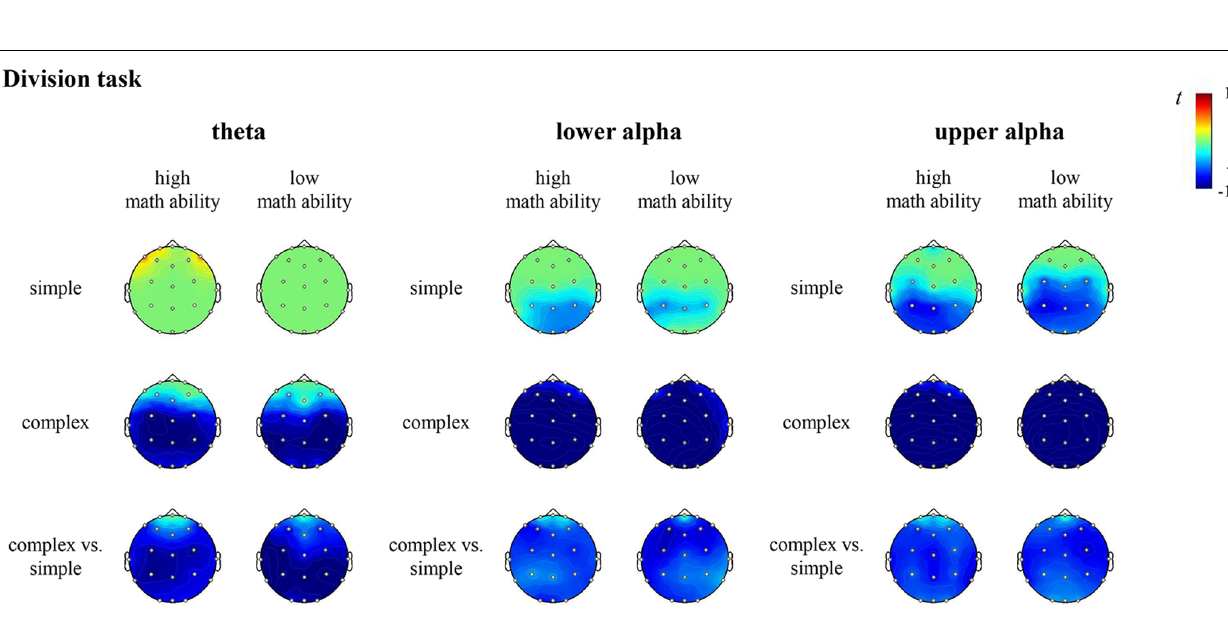
FIGURE 6 | T maps for the EEG data depicting theta, lower and upper alpha (de)synchronization during the division task for simple arithmetic problems, complex arithmetic problems and the contrast (complex vs. simple) for individuals with high math ability and low math ability. The colors indicate synchronization (yellow-red) and desynchronization (light-dark blue),